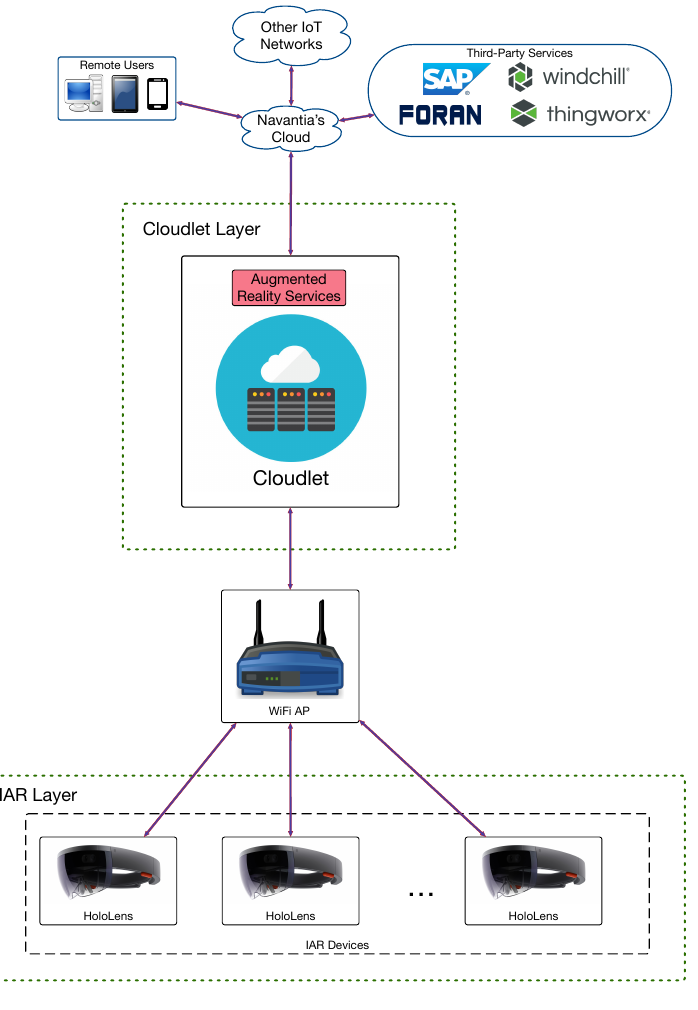
Figure 4. Implemented cloudlet-based architecture.